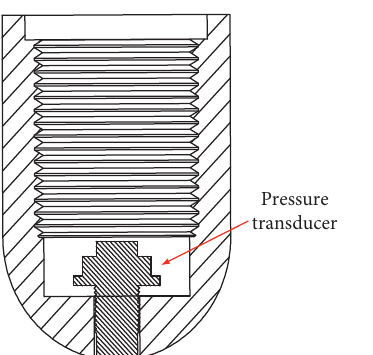
Figure 10: Pressure transducer on the hemispheric target. Table 3. The wall pressure-time curves corresponding to different dimensionless constants c are given in Appendix.